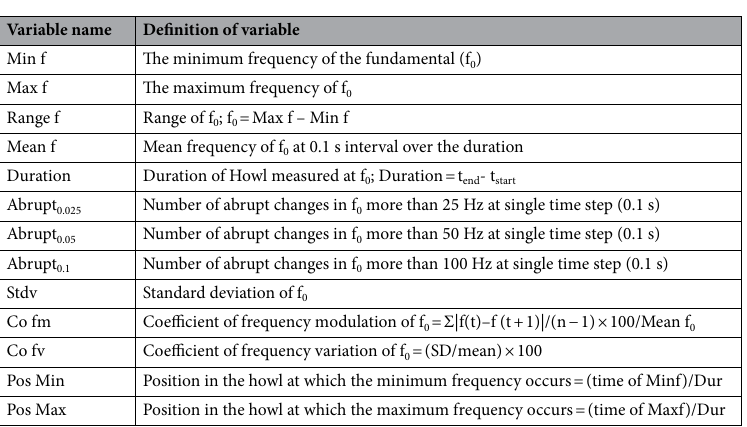
Table 1. Thirteen different variables that were measured from the fundamental frequency (f 0 ) [Lowest frequency of periodic waveform of each